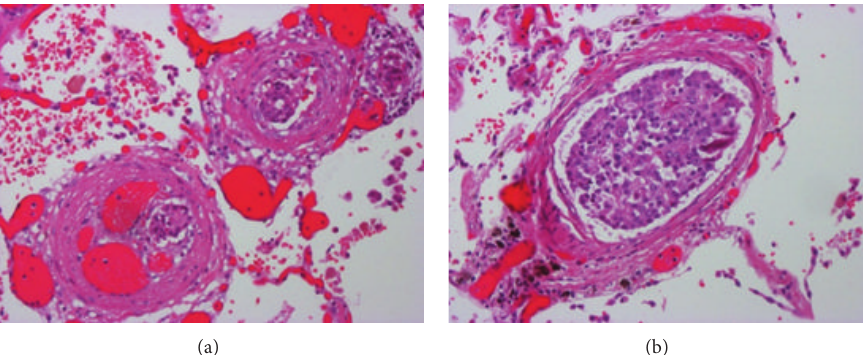
Figure 4: Lung tissue showing small and medium sized arteries with intimal thickening and luminal narrowing and recanalization, with tumor emboli present (hematoxylin-eosin, original magnification ×